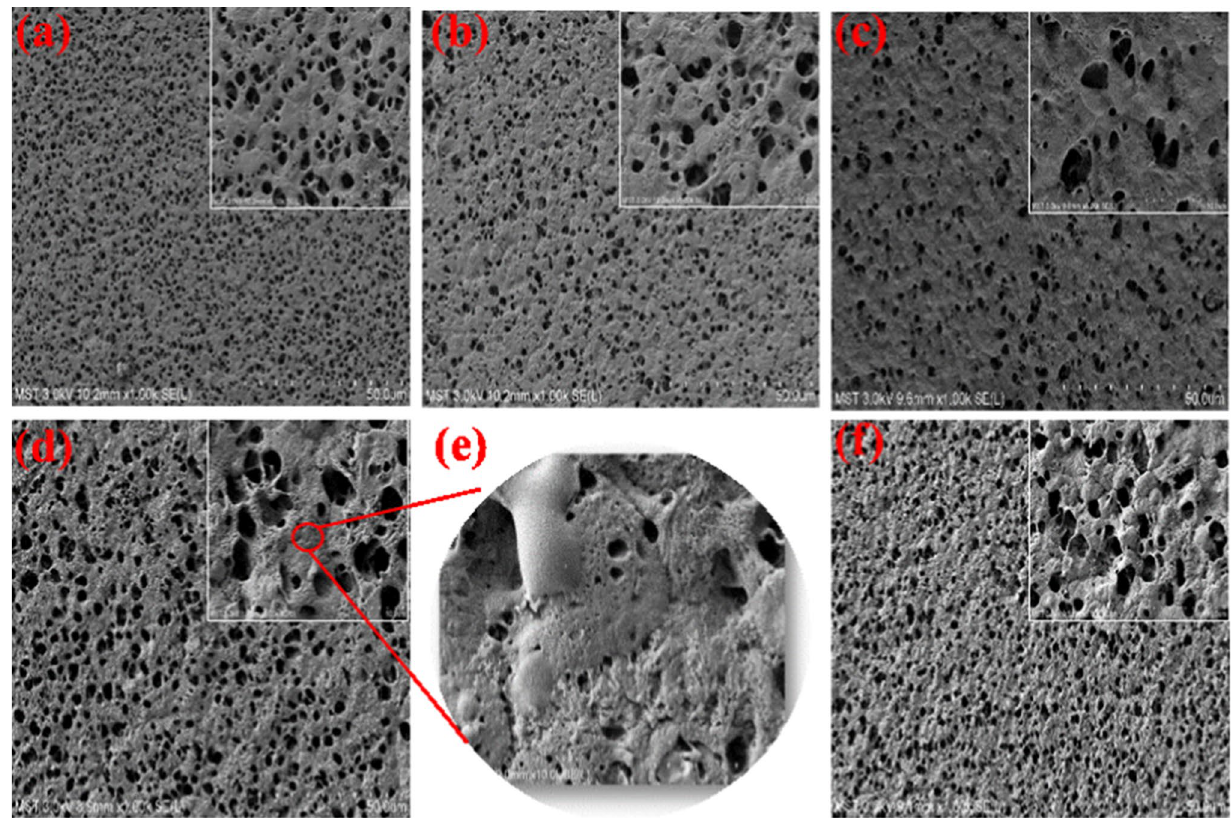
Fig. 2 Surface images of a M-Pristine, b M-coating, c M-Pristine after alkali treatment (NaOH (30 days), pH = 13), d , e M-UV curing, f M-UV curing after alkali treatment (NaOH (30 days), pH = 13). All